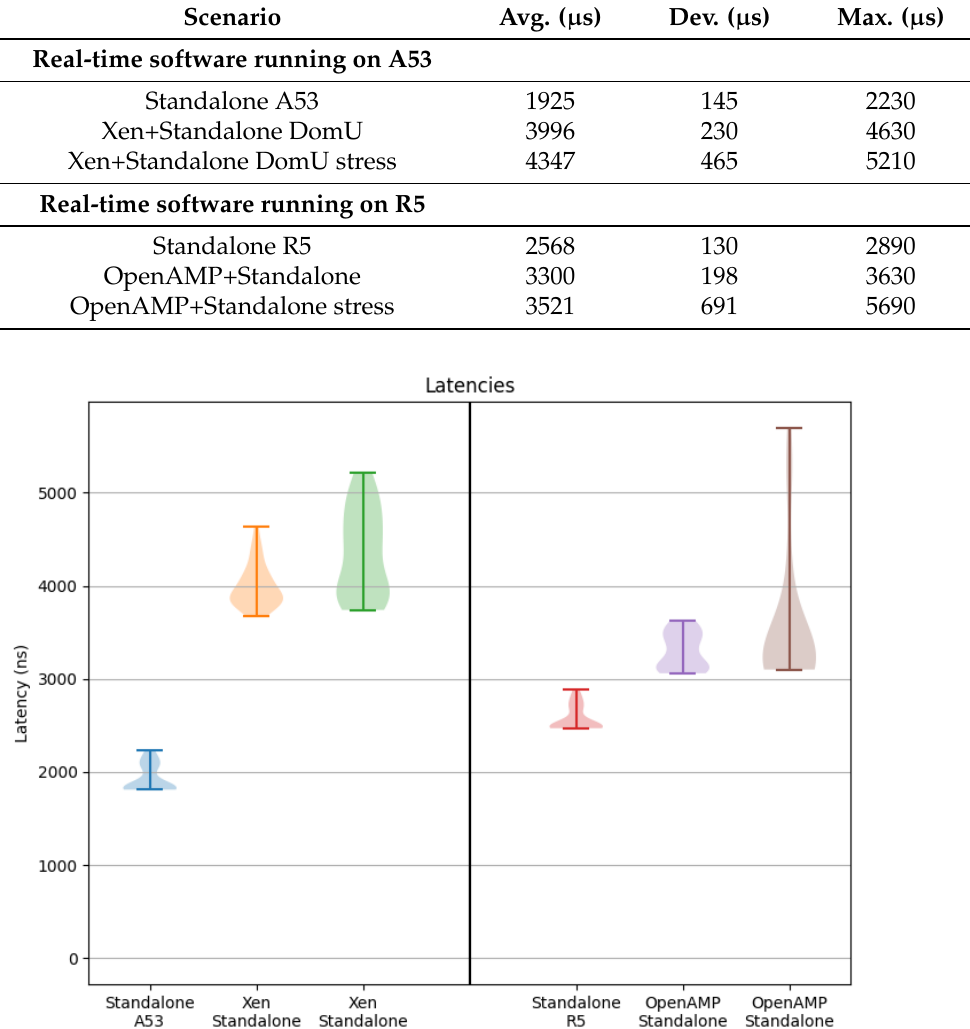
Table 3. Interrupt latency for 3 to 6 scenarios (Figures 5–8).